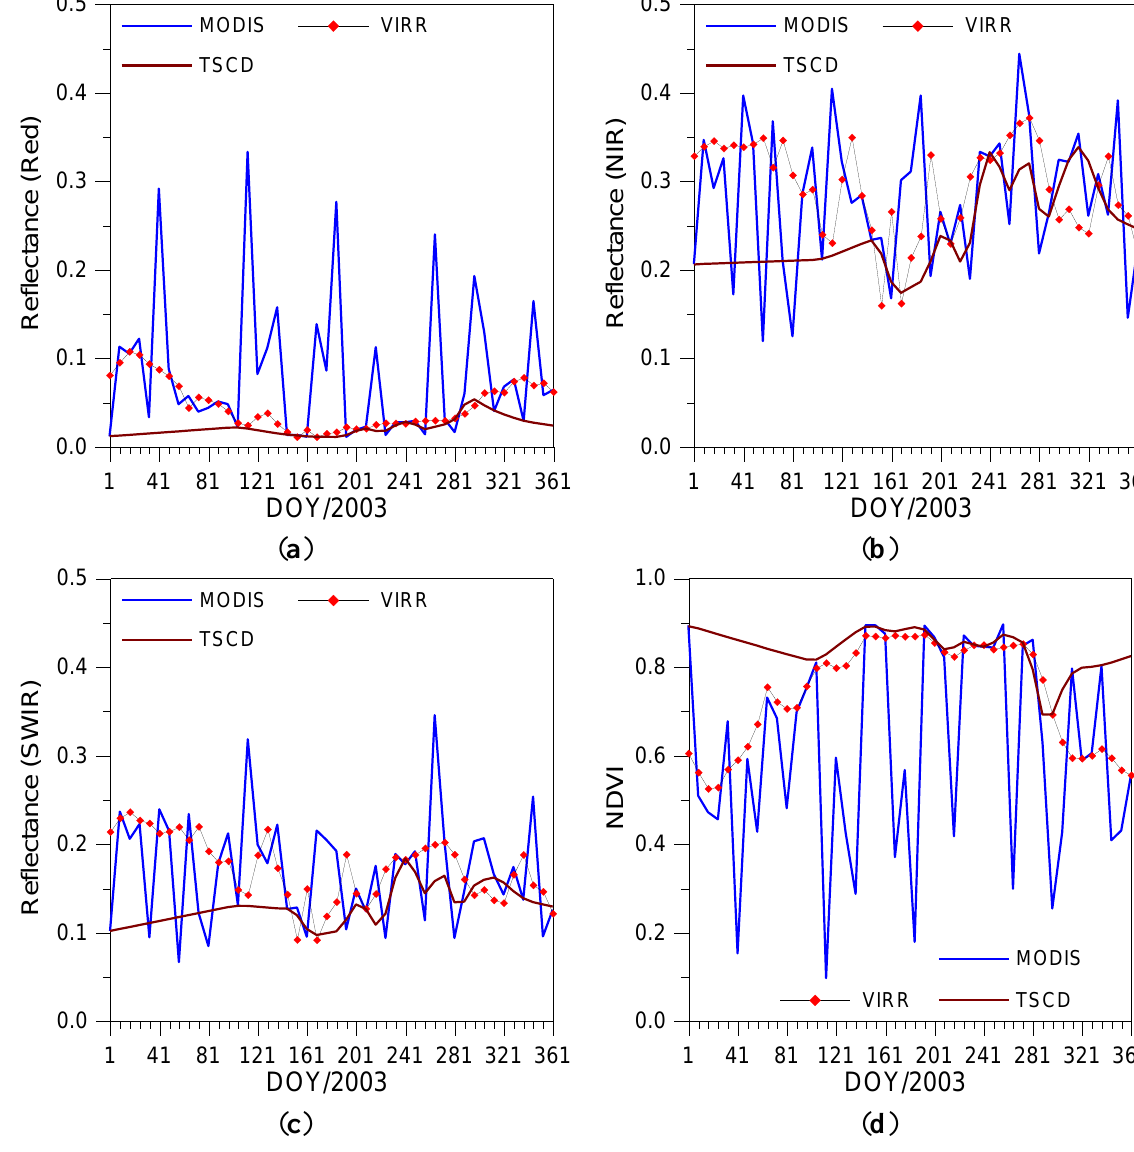
Figure 9. Time series of surface reflectance and NDVI from MOD09A1, the VIRR and TSCD algorithms for the center pixel of the Counami site in 2003. ( a ) surface reflectance in the red band; ( b ) surface reflectance in the NIR band; ( c ) surface reflectance in the SWIR band; ( d )